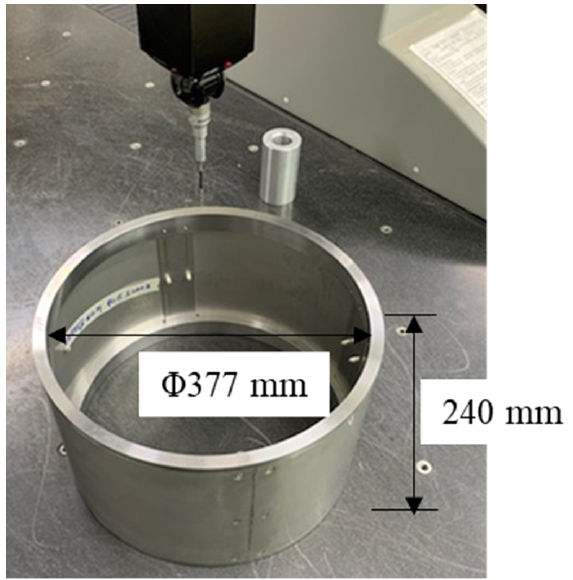
Figure 11. Welding-deformation measuring